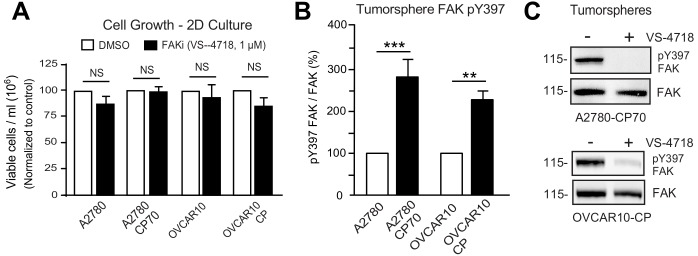
Constitutively elevated FAK Y397 phosphorylation in CP-resistant tumorspheres.(A) Growth of CP-sensitive (A2780 and OVCAR10) or CP-resistant (A2780-CP70 and OVCAR10-CP) cells in 2D culture + /- FAKi (VS-4718, 1 µM) over 72 hr. Values are means + /- SD from two independent experiments. NS, not significant. (B) The indicated cells were grown as tumorspheres (5 days), protein lysates analyzed by total FAK and pY397 FAK immunoblotting. LiCor quantitation of pY397 FAK to total FAK values are means + /- SD from three independent experiments (**p<0.01 and ***p<0.001). (C) A2780-CP70 and OVCAR10-CP tumorspheres [5 days] were treated with DMSO or FAKi (VS-4718, 1 µM) for 1 hr and lysates analyzed by total FAK and pY397 FAK immunoblotting.